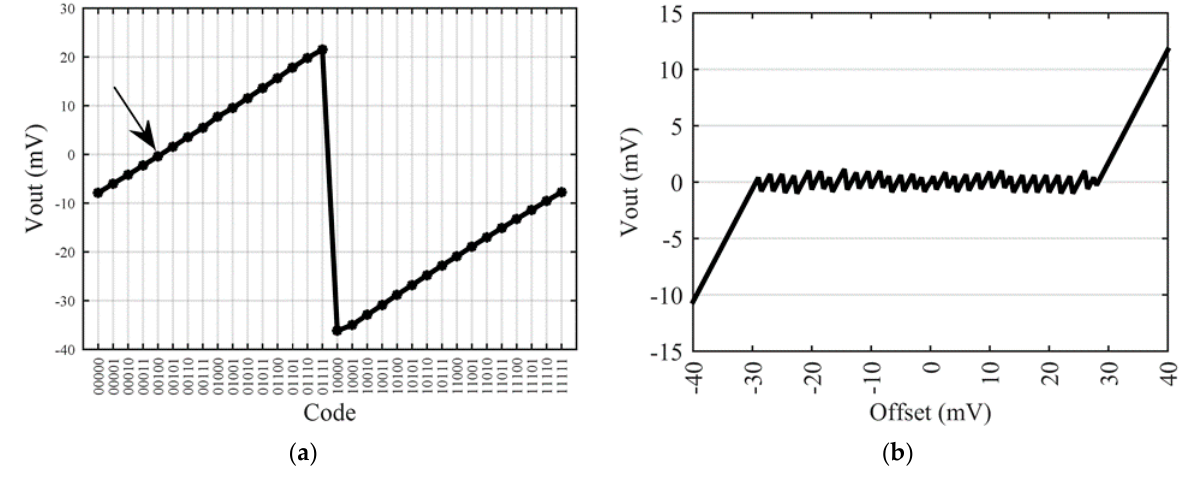
Figure 14. Measured output voltage of the smart-trimmed sensor after coarse tuning: ( a ) Sensor output voltage vs. 5-bits code with arrow representing optimal code for this example, ( b ) sensor output voltage vs. initial offset.